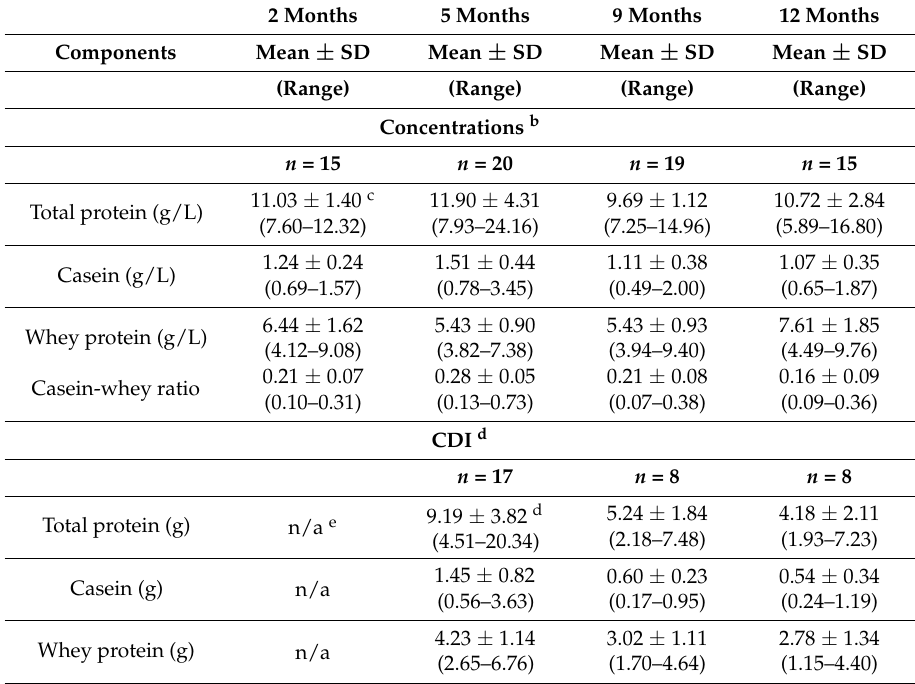
Table 3. Human milk proteins presented as concentrations and 24-h intakes at months after birth a